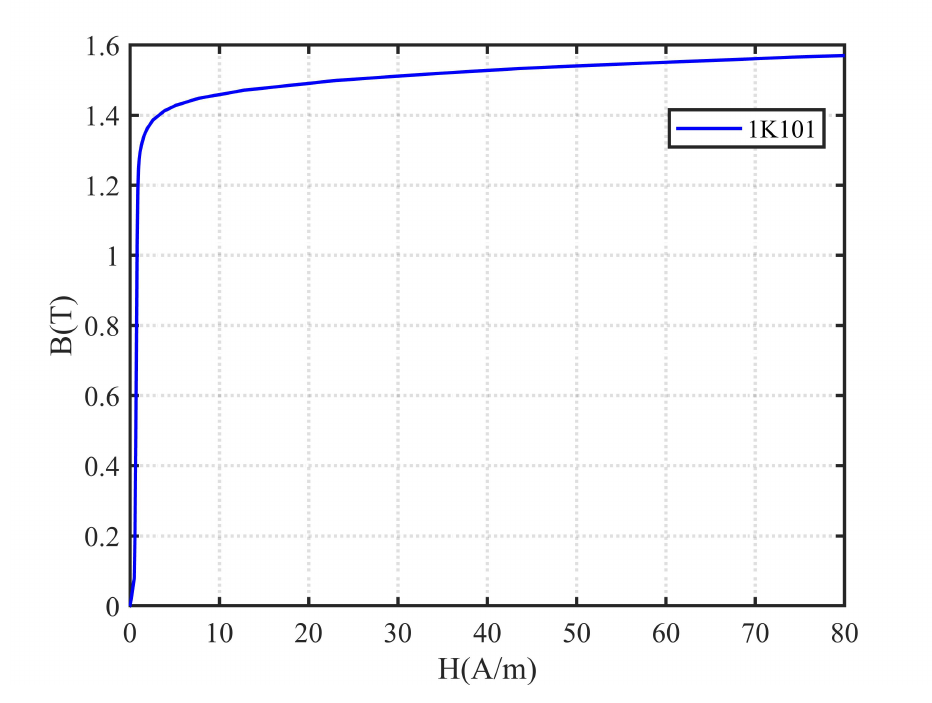
Figure 3. B-H Curves of 1K101.